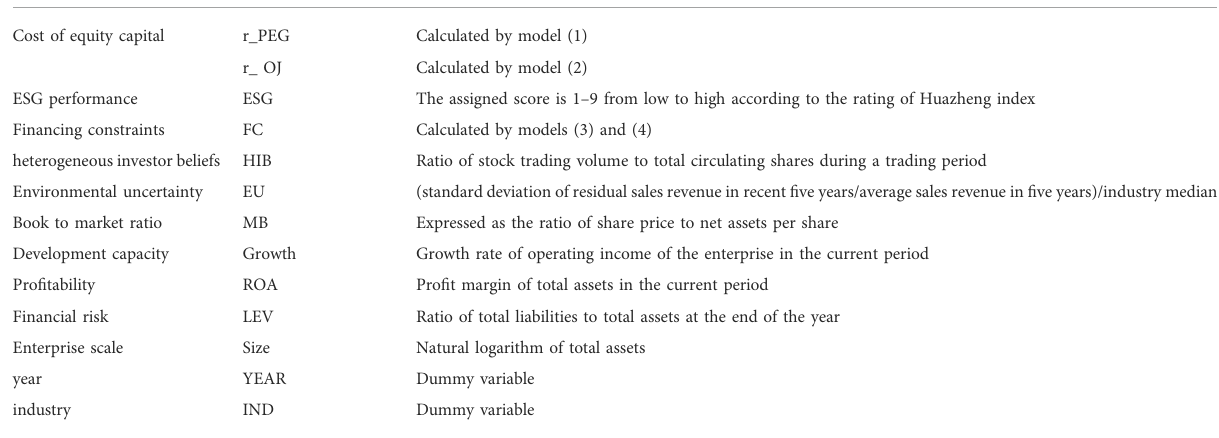
TABLE 1 De fifi nitions of